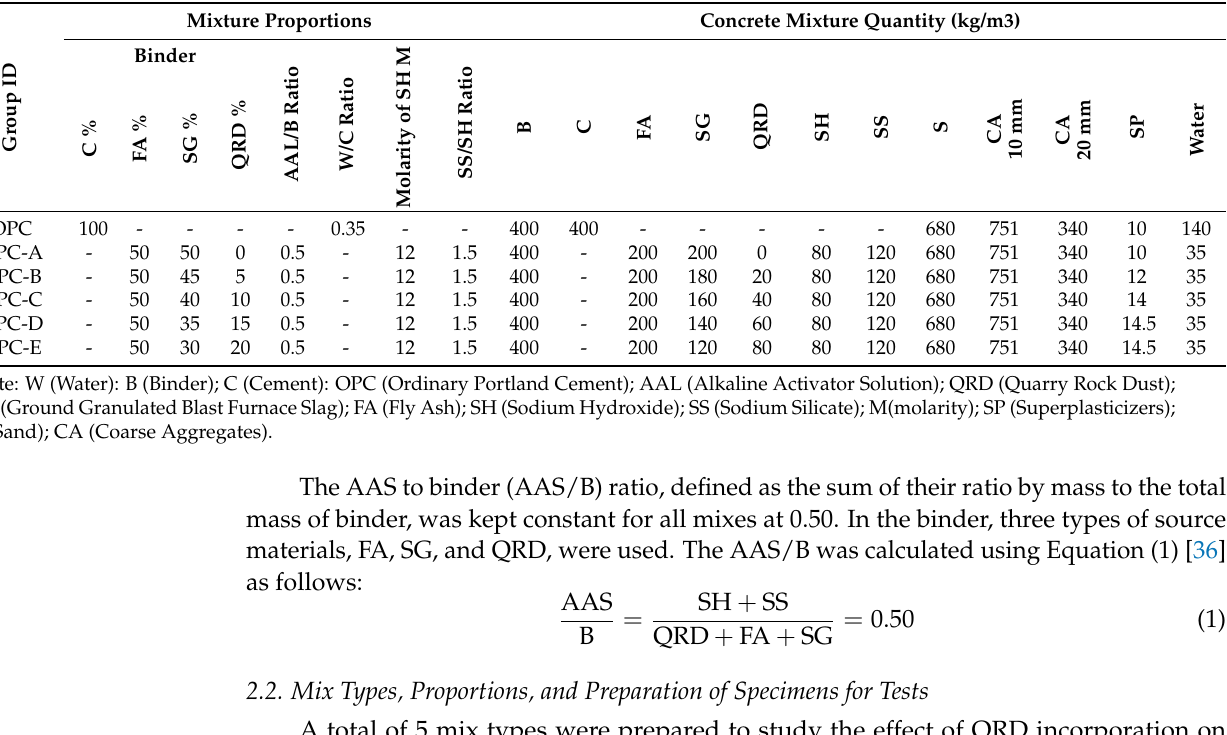
Table 5. The composition and proportions of mixes used in the